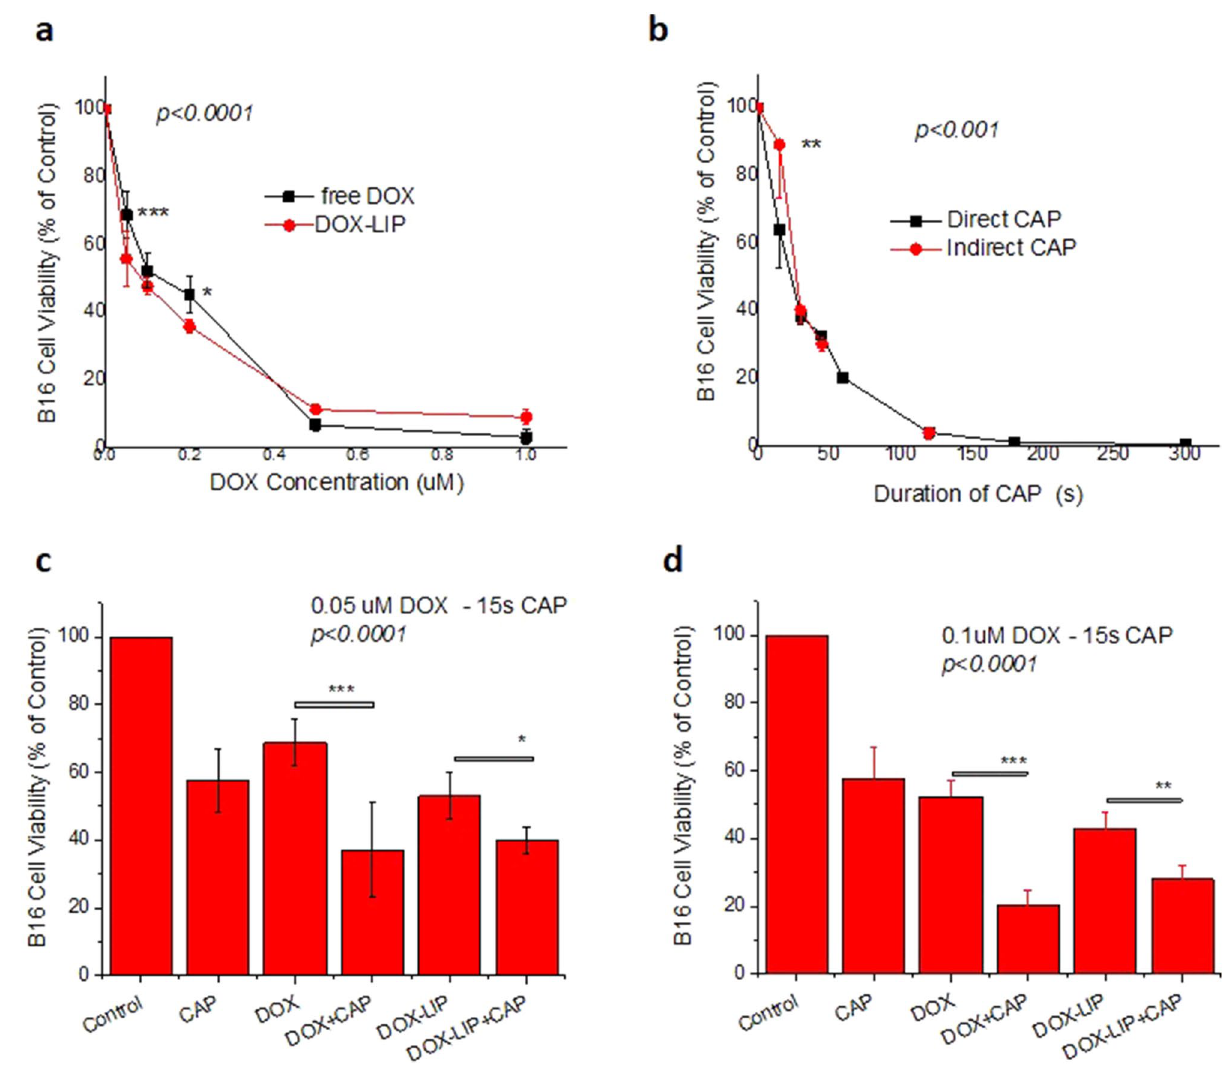
Figure 2. Effect of CAP and DOX or DOX-LIP on B16 cell viability. ( a ) Viability (% of control) of B16 cells after 48 h incubation in presence of various concentrations (0.05–1.00 μM) of DOX (free) and DOX-LIP. ( b ) Viability (% of control) of B16 cells after subjection to CAP for various time periods ranging between 15 and 300 s and incubation for 48 h. CAP was applied directly on the cells, or indirectly (on medium). Effect of CAP (15 s) and DOX or DOX-LIP on B16 cell viability, when applied separately or together, after 48 h of incubation with the cells ( c ) 0.05 μM DOX and ( d ) 0.1 μM Effect of CAP on DOX uptake by B16F10 cells.